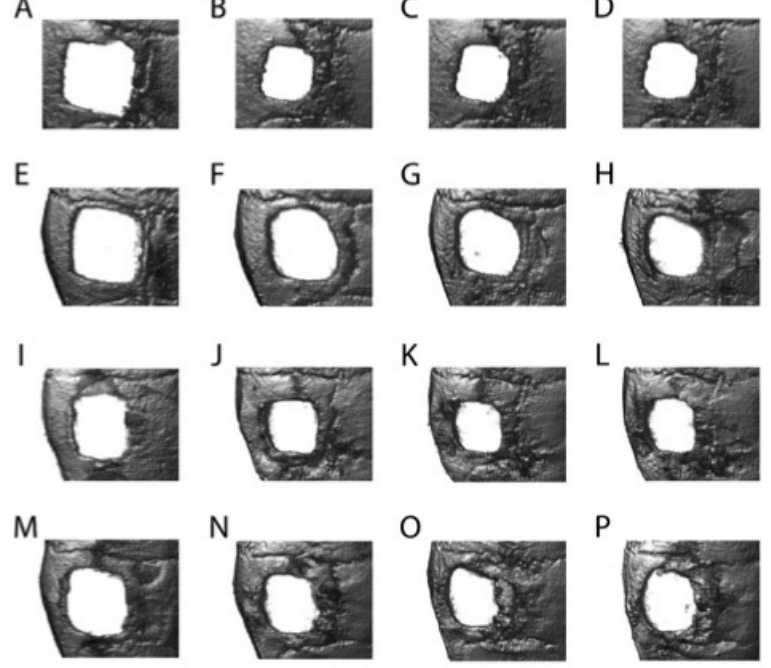
Figure 6. Top view of representative µCT scans of the defect of control group 1 (without implant; ( A – D )) as well as group 3 (hybrid implant; ( E – H )), group 4 (hybrid implant + murine osteoblasts; ( I – L )) and group 5 (hybrid implant + mADMSCs; ( M – P )) at days 0 ( A , E , I , M ), 28 ( B , F , J , N ), 56 ( C , G , K , O ) and 84 ( D , H , L , P ). For any other but the control group the implant was cut out in order to have a proper view of the